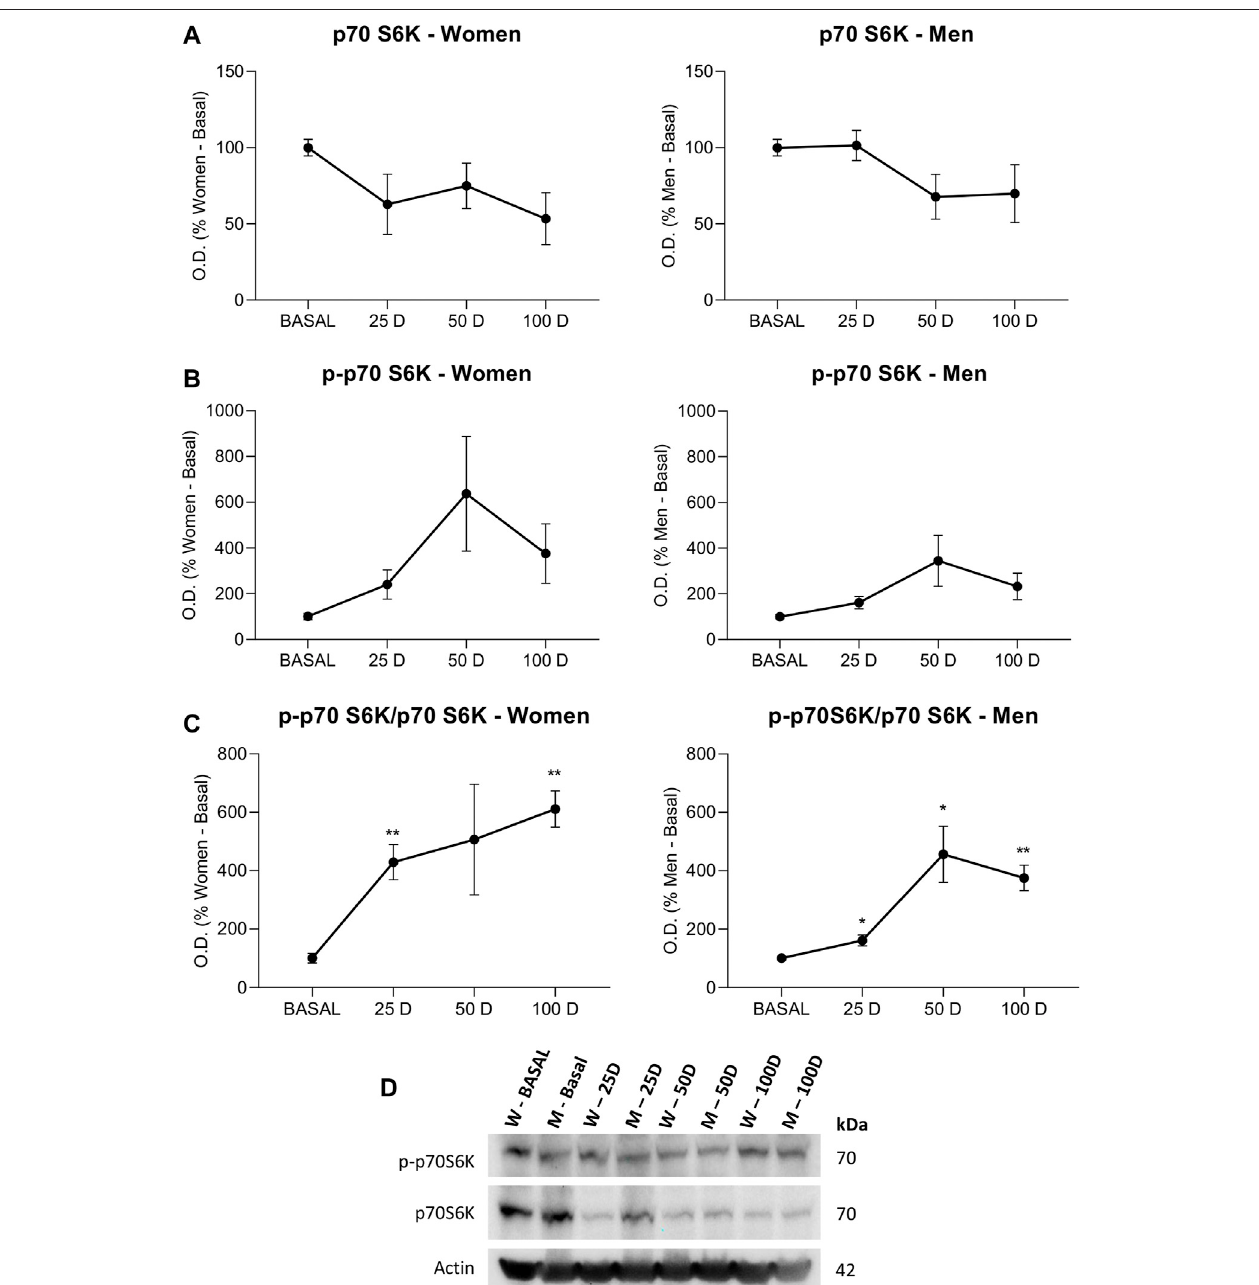
FIGURE 4 | Western blot analysis for studying protein synthesis pathway in lymphocytes extracted from women and men at baseline (BASAL), 25 days (25 D), 50 days (50 D) and 100 days (100 D). Bar chart showing the optical density (OD) (Arbitrary units) of blot bands of (A) p70S6K, (B) p — p70S6K and (C) p — p70S6K/ p70S6K, (D) Images of representative inmunoblots. Actin was used as a loading control. Data are mean ± SEM. *BASAL vs. 25 D, 50 D and 100 D. The number of symbols marks the level of signi fi cance: one for p < 0.05, two for p < 0.01 and three for p < 0.001.